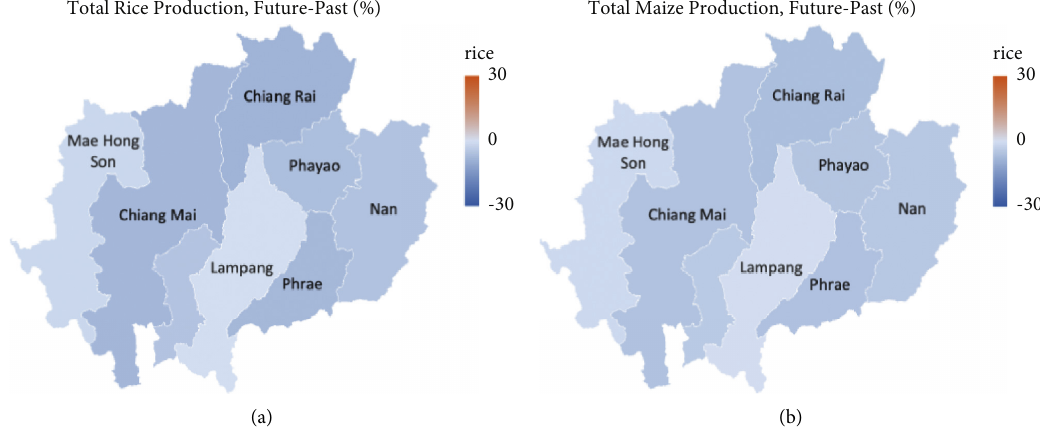
Figure 5: The percentage difference in the years 2020–2029 of total rice and maize production in northern Thailand (adapted from reference